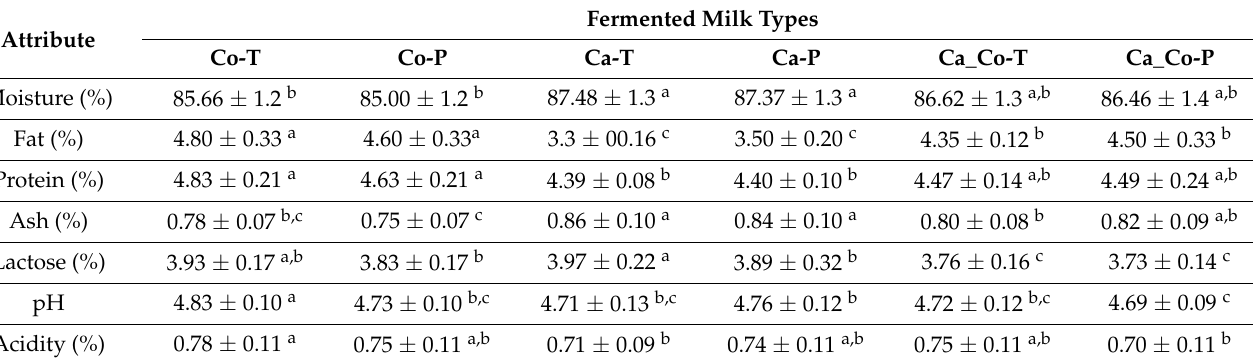
Table 1. Chemical composition of different fermented